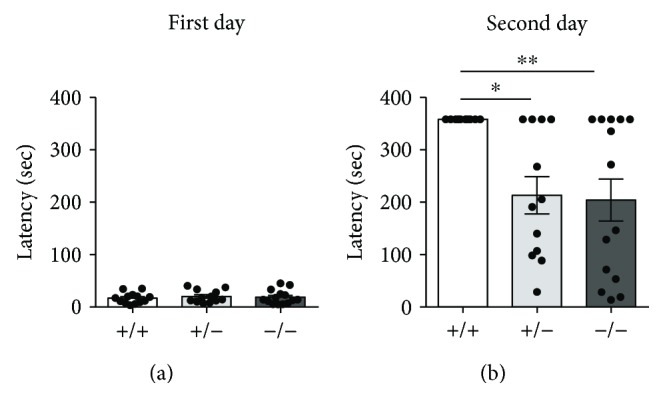
Impaired memory in Cdkl5 +/− female mice. (a, b) Passive avoidance task to measure memory that involves contributions from both the hippocampus and amygdala. On the first day (a), no difference was observed between genotypes regarding the latency to enter the dark compartment. On the second day, Cdkl5 +/− (n = 12) and Cdkl5 −/− (n = 14) mice showed a decreased latency to enter the dark compartment compared to Cdkl5 +/+ (n = 13) mice, indicating defects in memory. Values represent mean ± SEM. ∗
p < 0.05 and ∗∗
p < 0.01 (Dunn's test after Kruskall-Wallis).